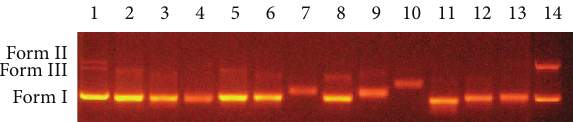
Figure 1: Electrophoretic mobility of pUC19 plasmid DNA. Lane 1: DNA, Lane 2 ∼ 4: DNA + PtL a Cl 2 (50, 100, 200 𝜇 M), Lane 5 ∼ 7: DNA + PtL b Cl 2 (50, 100, 200 𝜇 M), Lane 8 ∼ 10: DNA + PtL c Cl 2 (50, 100, 200 𝜇 M), and Lane 11 ∼ 13: DNA + PtL d Cl 2 (50, 100, 200 𝜇 M), and Lane 14: DNA + CDDP (40 𝜇 M).